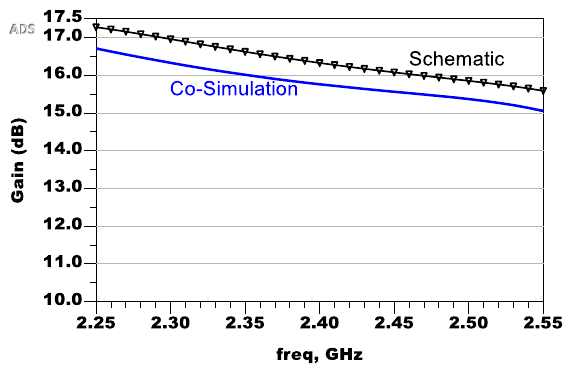
Fig. 15. Small signal gain versus